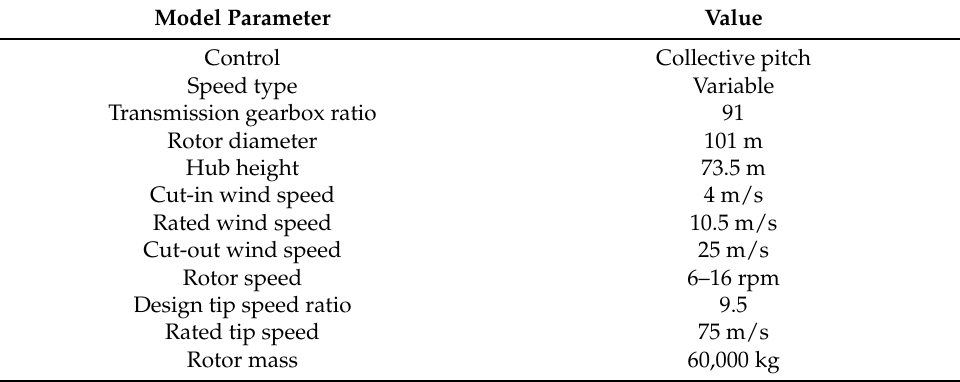
Table A1. The key parameters of the base aeroelastic